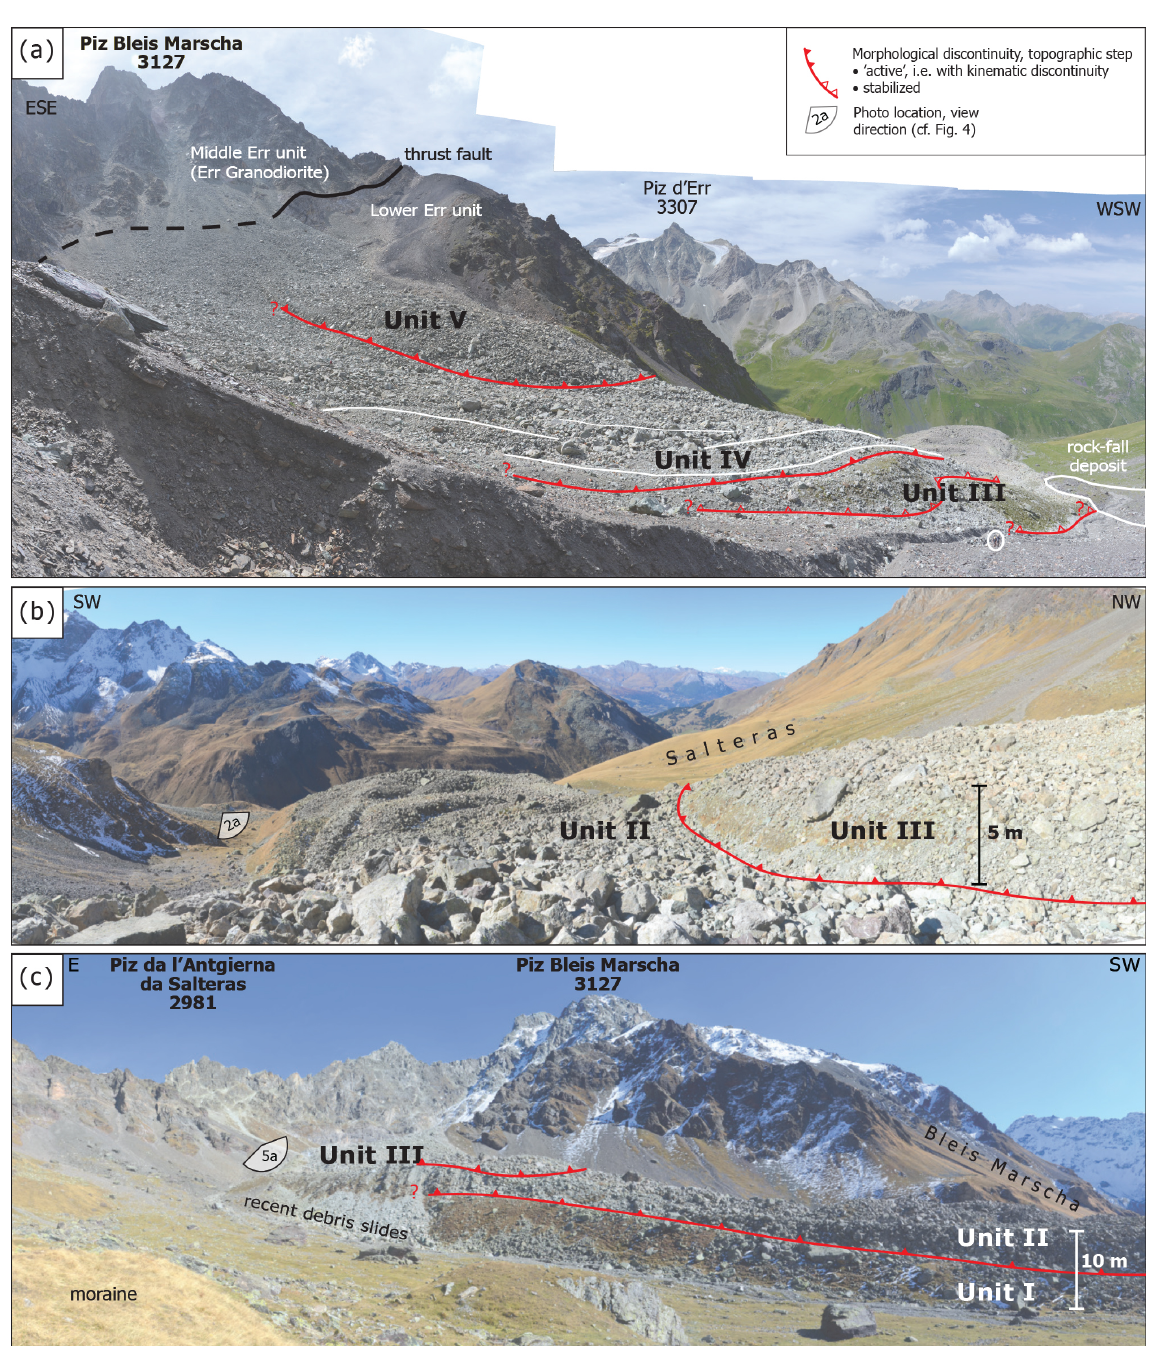
Figure 5. Panorama views of the Bleis Marscha rock glacier (see Fig. 4 for photo locations). (a) View to the southeast into the root zone in Piz Bleis Marscha cirque. The dominant lithology of the boulder mantle, Err Granodiorite, is sourced above the thrust fault in the back of the cirque. Photo taken in August 2018. (b) View to the west onto lower rock glacier part with furrow-and-ridge microtopography (unit II). The currently advancing unit III is outlined by the prominent terrain step. Photo taken in October 2018. (c) Side view to the southeast of the middle rock glacier part, evidencing the Bleis Marscha rock glacier as a multi-unit debris stream composed of multiple stacked lobes. The fresh lateral debris apron poured over the stabilized, grassy sidewall along unit III hints at recently increased activity (possible reactivation). Unit I at the base of the stack is discernible by the stable, grassy sidewall and the ledge beneath unit II. Photo taken in October 2018.